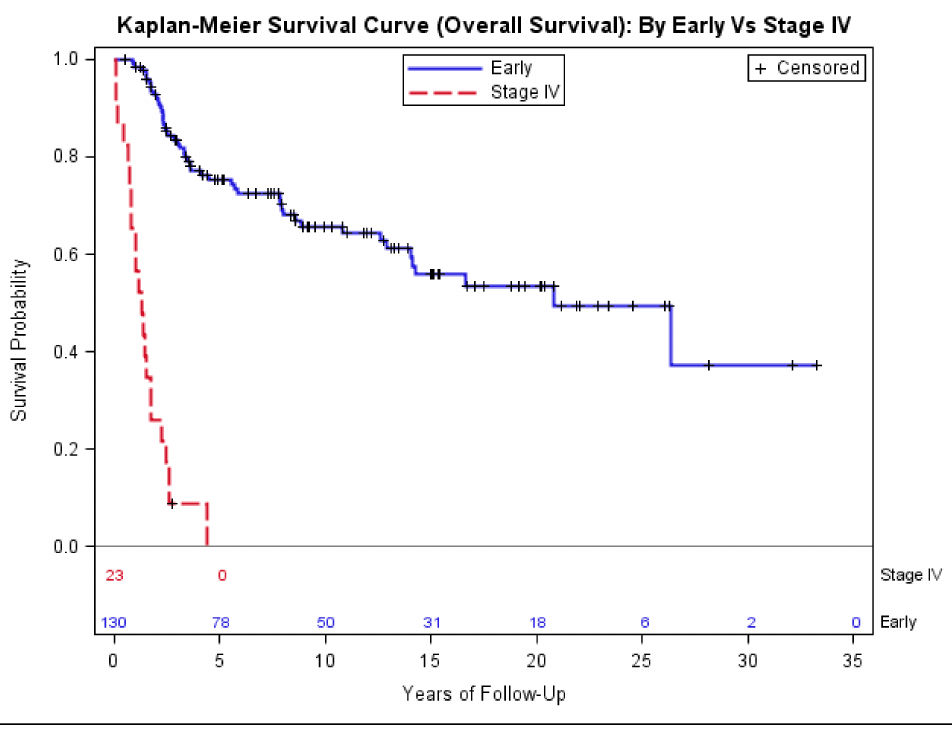
Figure 1. Kaplan–Meier estimates of overall survival of patients with stage IV and early-stage synovial